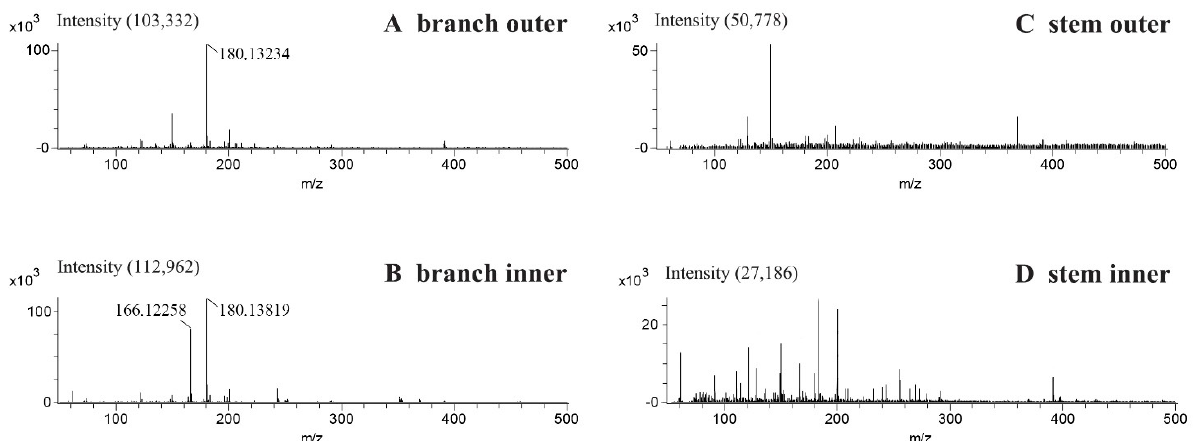
Figure 2. Representative direct analysis in real time-time of flight-mass spectrometry (DART-TOF-MS) spectra of the outer surface ( A ) and an inner surface ( B ) of a branch and outer surface ( C ) and an inner surface ( D ) of the main stem (woody stem) of ephedra aerial parts.